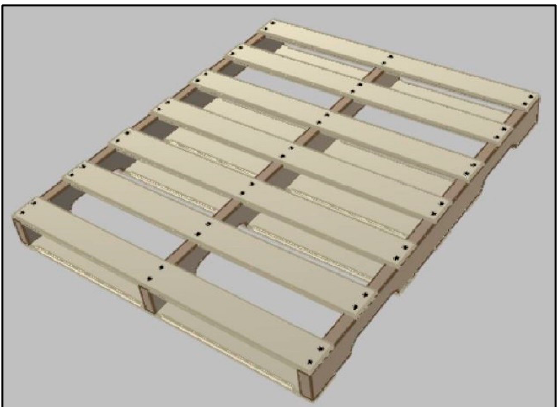
Figure 1. Picture of GMA pallet used for software validation (image generated using PDS™).